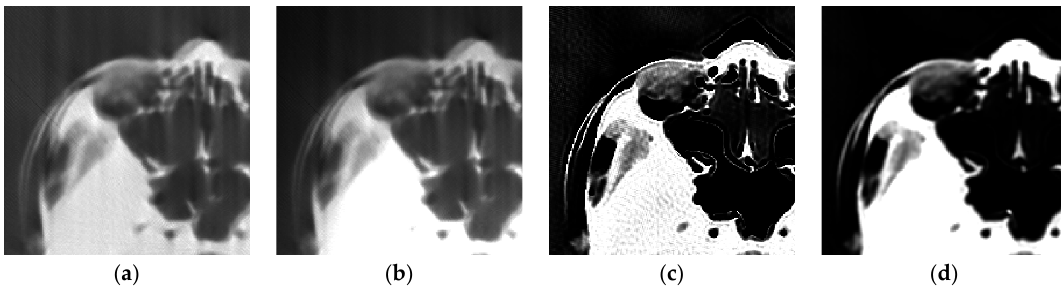
Figure 7. Zoomed images of a region of interest (ROI) from Figure 6. Table 3. Evaluation of motion artifact reduction performance on head phantom.